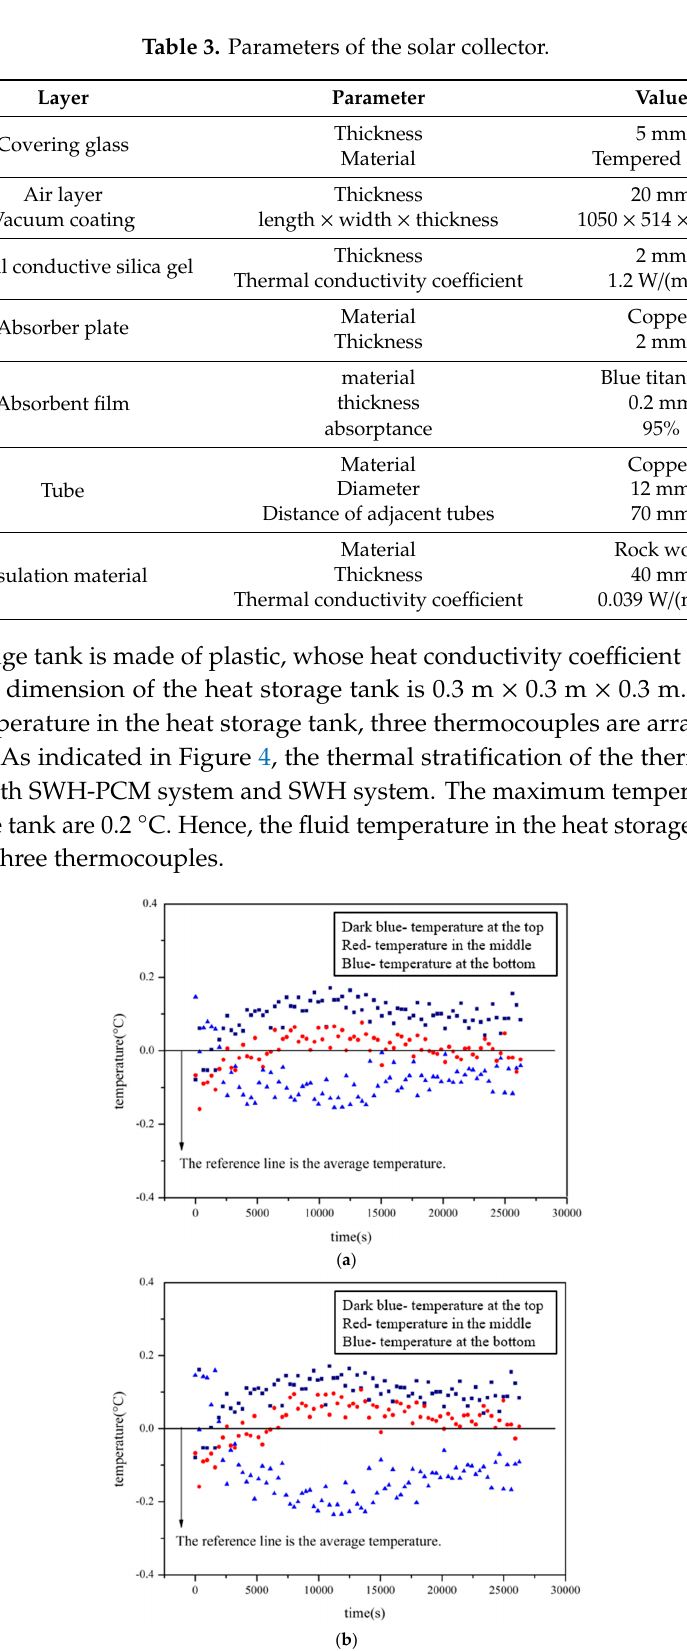
Figure 4. Temperature distribution in the vertical direction of the thermal storage tank. ( a ) Solar water heating-phase change material (SWH-PCM) system; ( b ) Solar water heating (SWH) system.